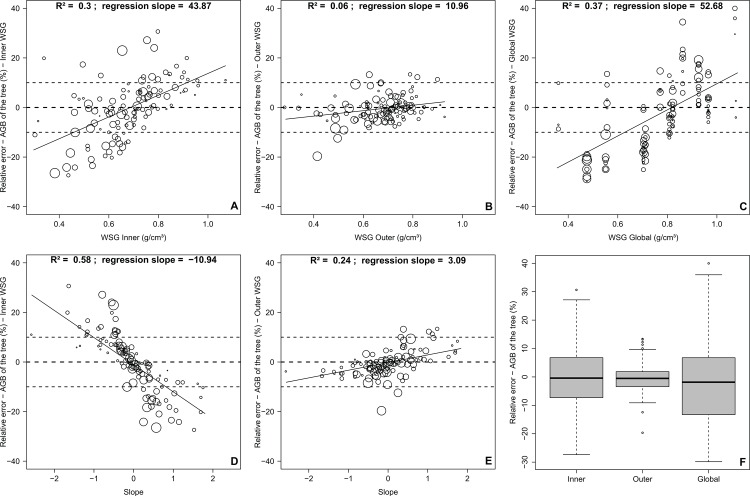
Relative error of the estimation of the AGB for each sampled tree in Malebo, the Democratic Republic of the Congo.Relative errors were calculated using weighted-WSG as reference and using the inner-WSG (A,D), the outer-WSG (B,E) and the global-WSG (C) as estimators. The dependence of the relative error was tested against the absolute value of WSG and against the slope. The size of the dots is proportional to tree diameter. The final boxplots summarize the distribution of the errors according to each estimator (F).